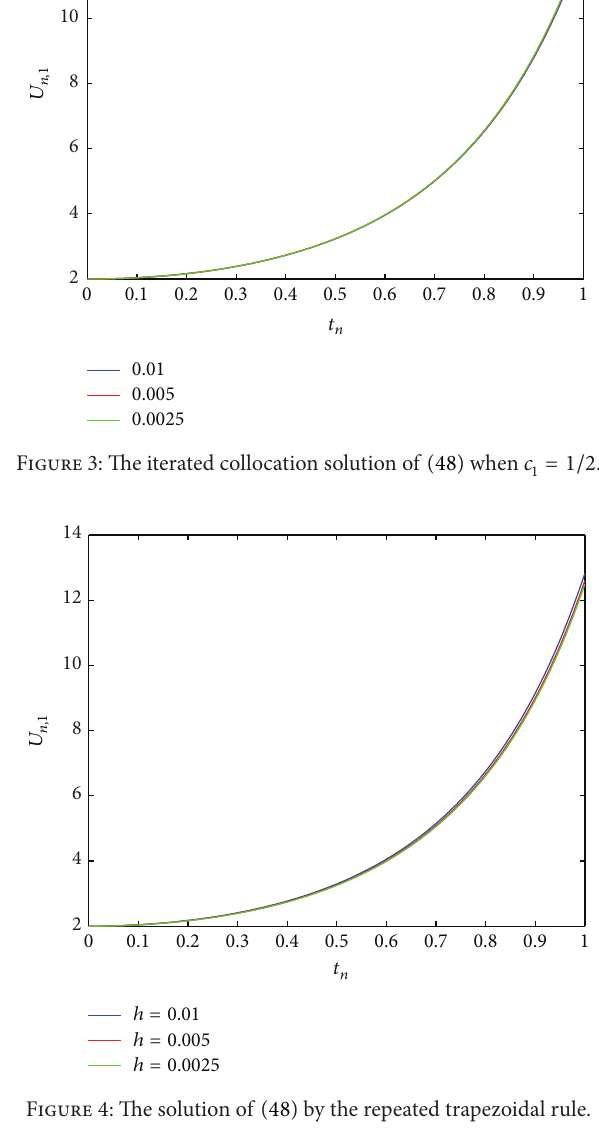
Figure 2: The collocation solution of (48) when 𝑐 1 = 1/2 . 4.1.4. Using Repeated Trapezoidal Rule. For the VIE (48) 𝑢(0) = 2 and